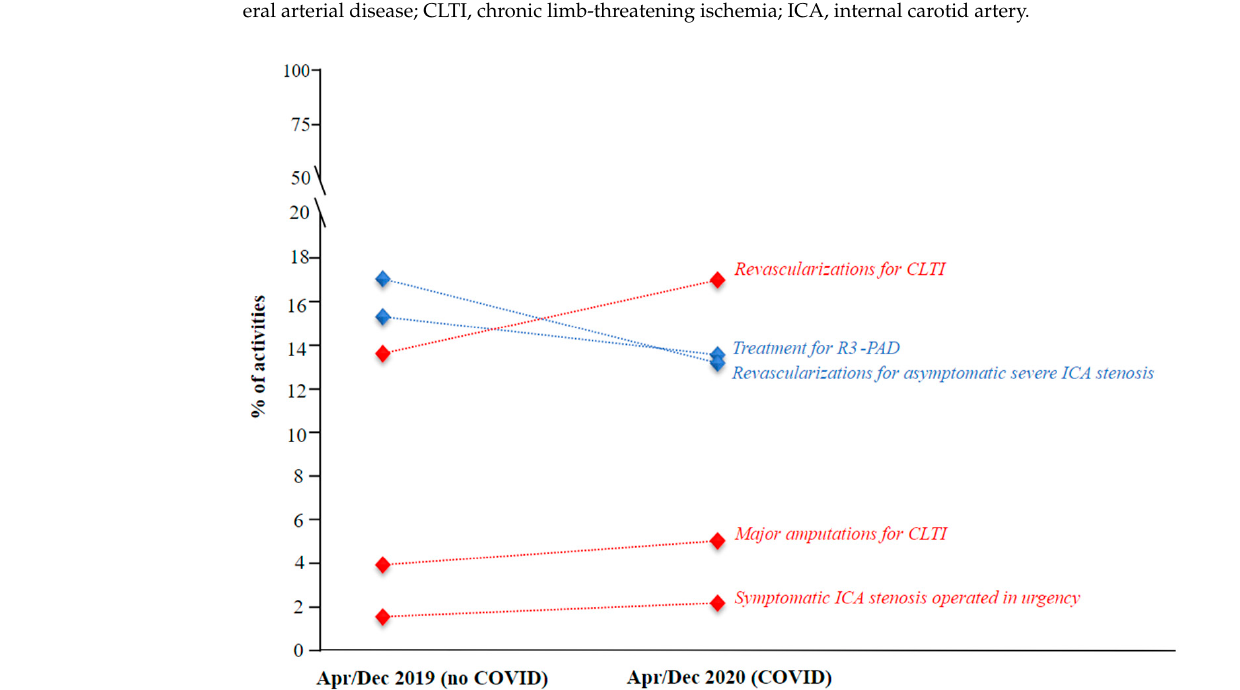
Figure 2. Graphic of the main results for the COVID-19 period from April to December 2020 compared with the non-COVID-19 period from April to December 2019. CLTI, chronic limb-threatening ischemia; R3-PAD, Rutherford category 3 peripheral arterial disease; ICA, internal carotid artery. Blue indicates elective procedures; red indicates urgent procedures.